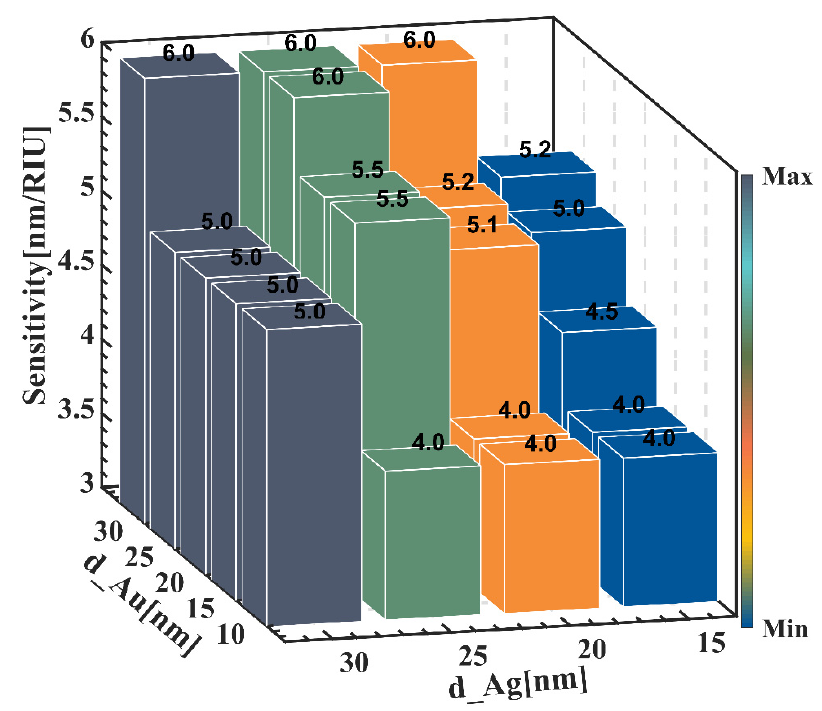
Figure 4. Sensitivity corresponding to different gold and silver film thicknesses.